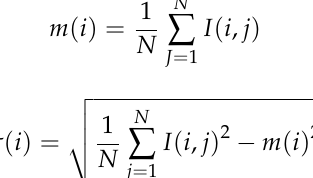
Figure 10. The two steps of the Sigma algorithm that, starting from the initial Image I, produce a result Image R that is used for classification. The k C and k R are the algorithm’s parameters. Classification generates a list of defects with their size (blobs and air lines).